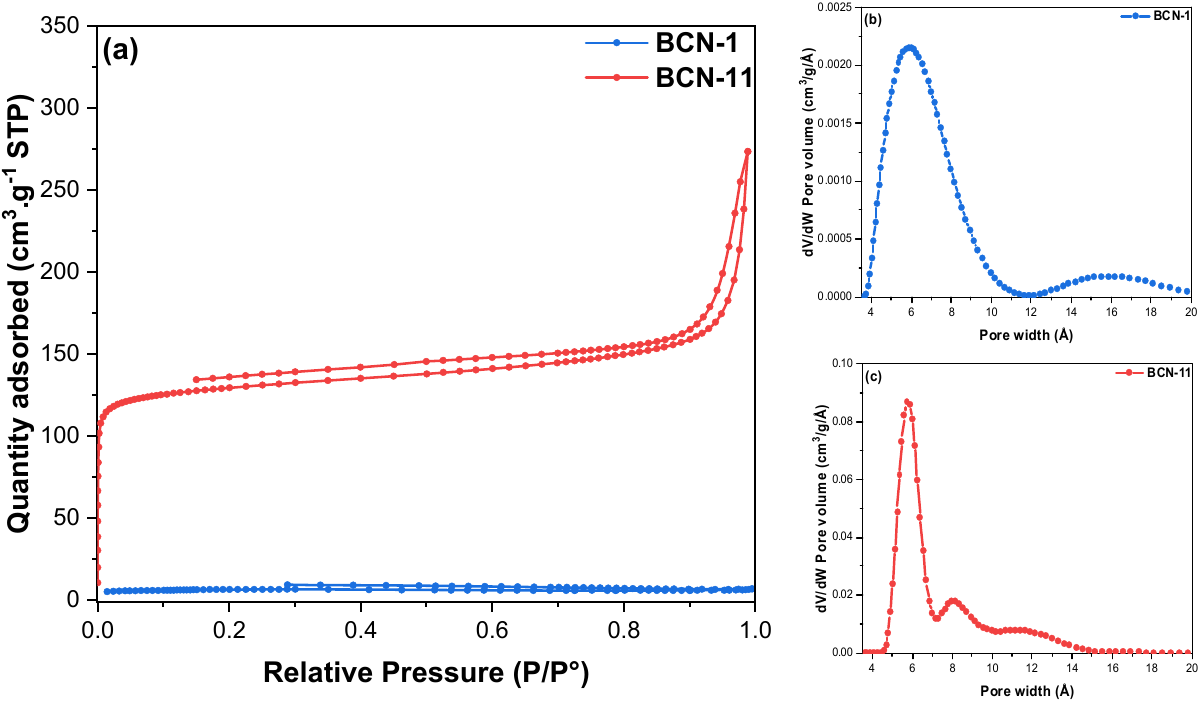
Figure 1. ( a ) Nitrogen adsorption–desorption isotherms at − 196 °C of BCN − 1 and BCN − 11; ( b , c ) Pore size distribution of BCN − 1 and BCN − 11 by NLDFT method.